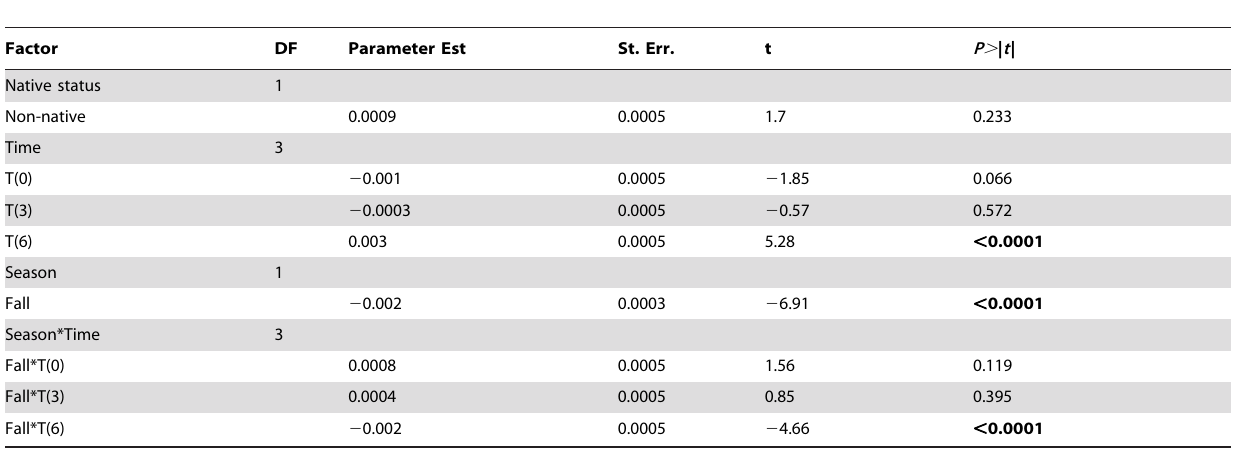
Table 3. Results from a mixed-effects model testing native status, season, time and the interaction of season and time across 15 N concentrations in roots of L. japonica , L. sempervirens , F. alnus , and R. alnifolia .